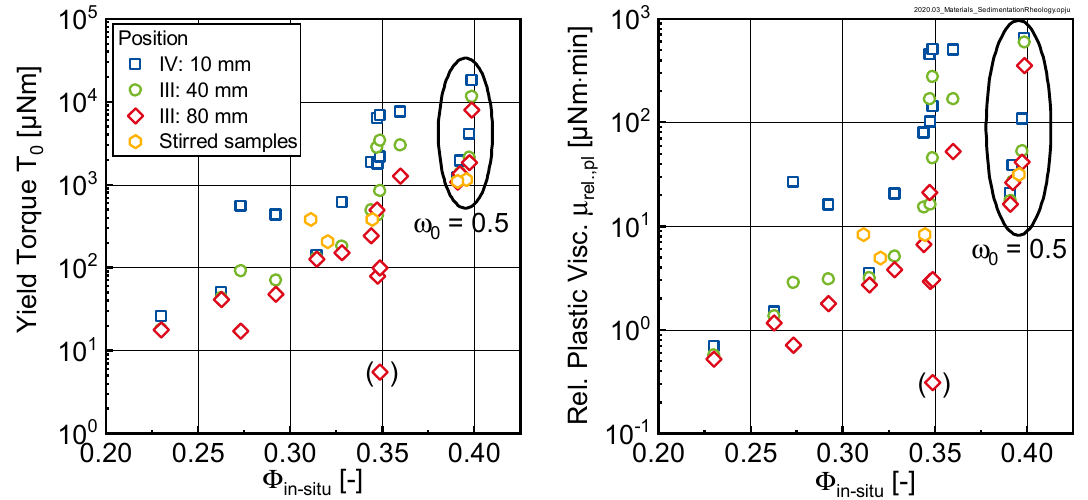
Figure 12. Yield torque T 0 (left) and relative plastic viscosity µ rel.,pl (right) as a function of the in-situ phase content φ insitu for different measurement positions I–IV